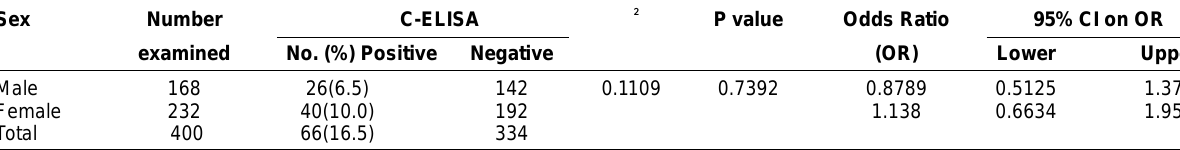
Table-1. Sex specific prevalence of Brucella antibodies in camel herds in Yobe state